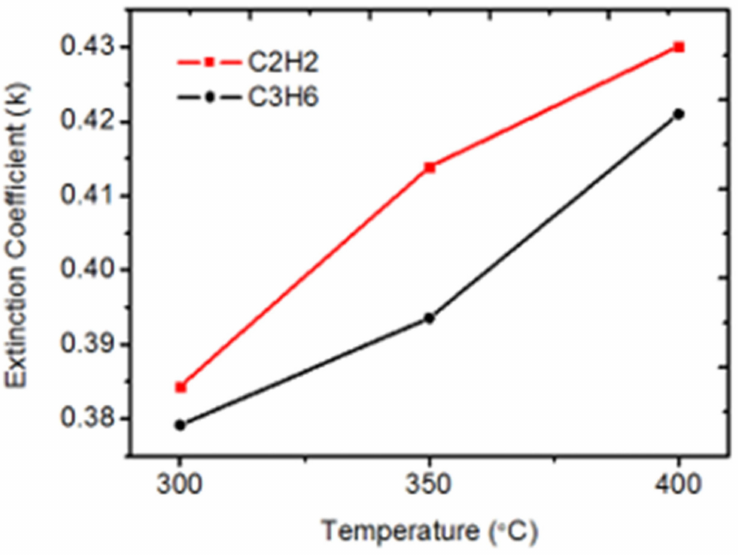
Figure 2. The profile of the extinction coefficient as a function of deposition temperature.